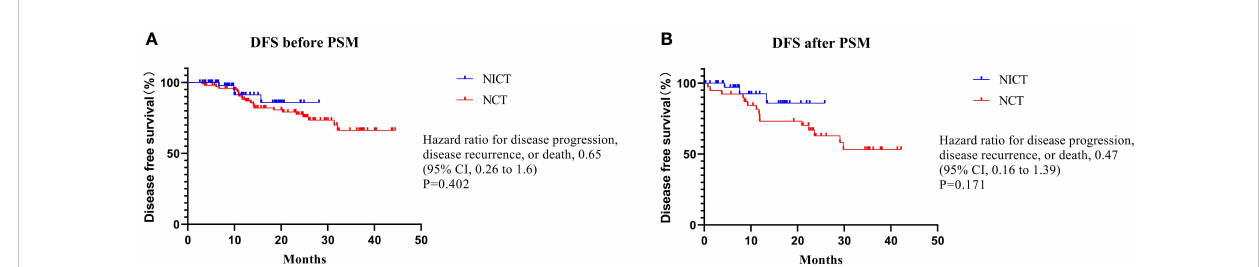
FIGURE 1 Disease free survival Summary. There was no statistically signi fi cant difference in DFS before or after